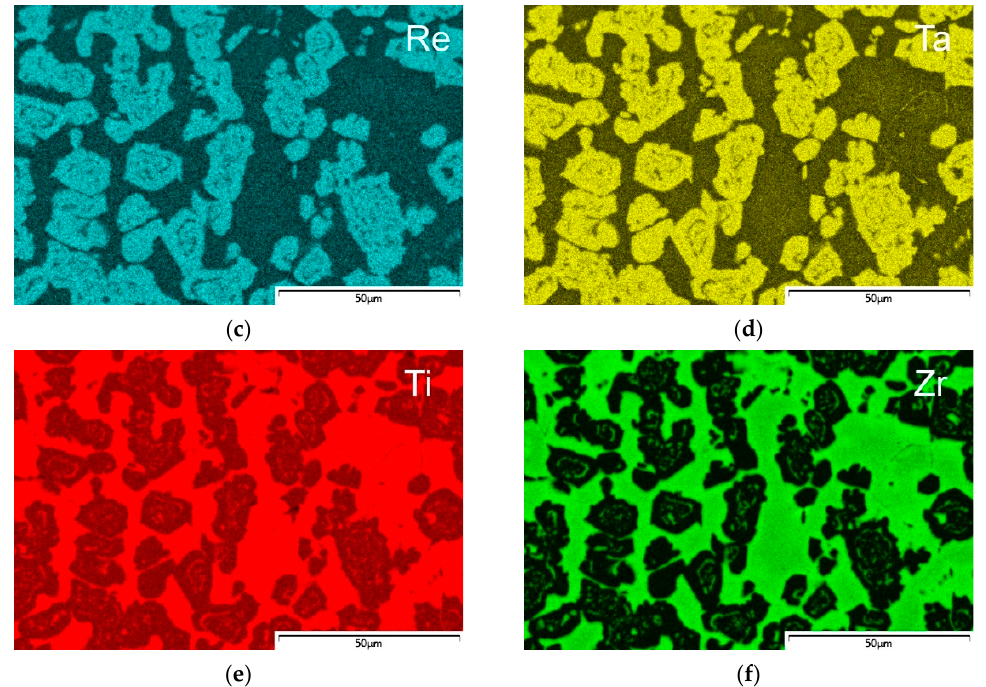
Figure 10. ( a ) Low magnification and ( b ) higher magnification SEM images of the two-phase microstructure of the HIP’d Re0.3TaTiZr alloy. ( c – f ) Element composition maps of ( c ) Re, ( d ) Ta, ( e ) Ti, and ( f ) Zr taken from the area shown in figure ( b ). Table 7. Chemical composition (in at.%) and volume fraction (V f ) of the matrix phase and second- phase particles in the HIP’d and deformed Re 0.3 TaTiZr alloy samples.